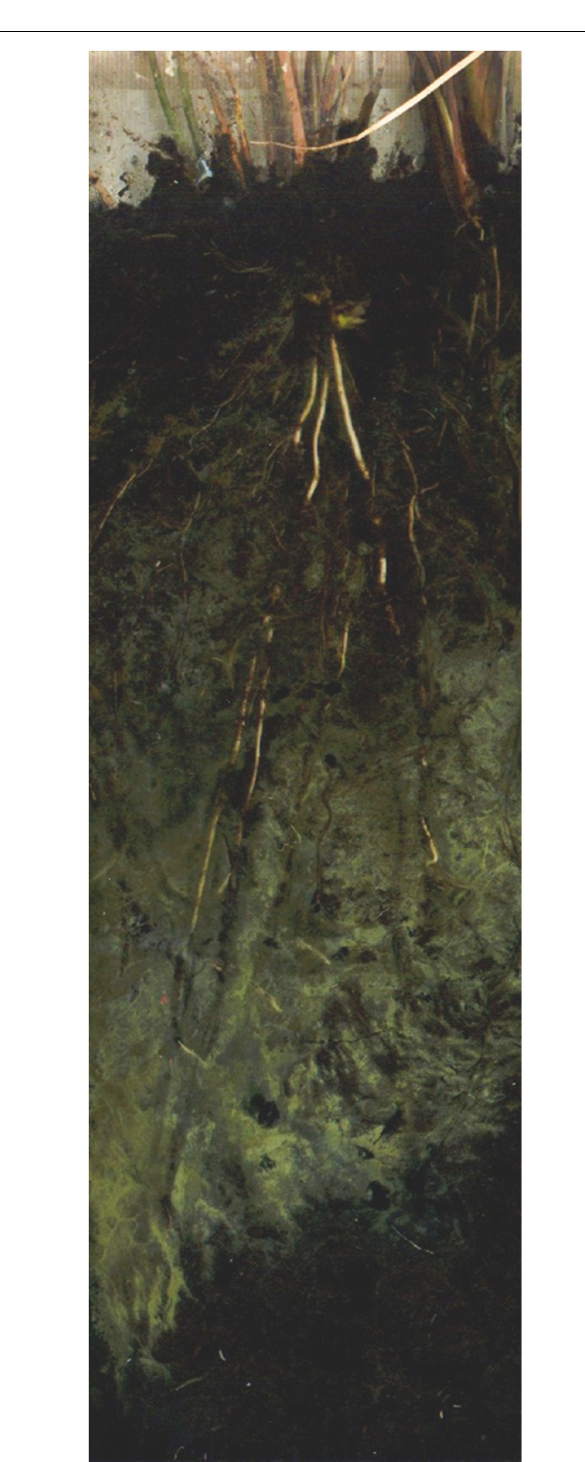
FIGURE 3 | Radial oxygen loss (ROL) of Juncus acutiflorus is shown by the oxidation of added H 2 S in an anaerobic rhizotron with living plants and natural organic wetland soil. This was confirmed by the use of oxygen microelectrodes.Yellow-whitish haloes of S 0 and S precipitates have been formed by microbial S oxidation (Lamers and Janssen, unpublished